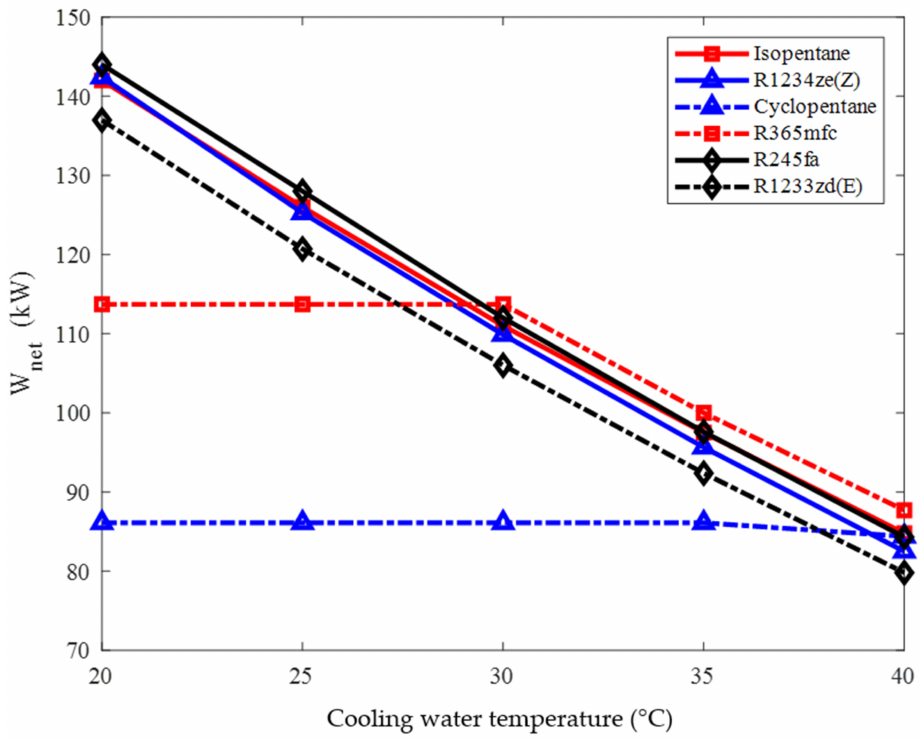
Figure 12. Effect of the cooling water temperature on the net power output.